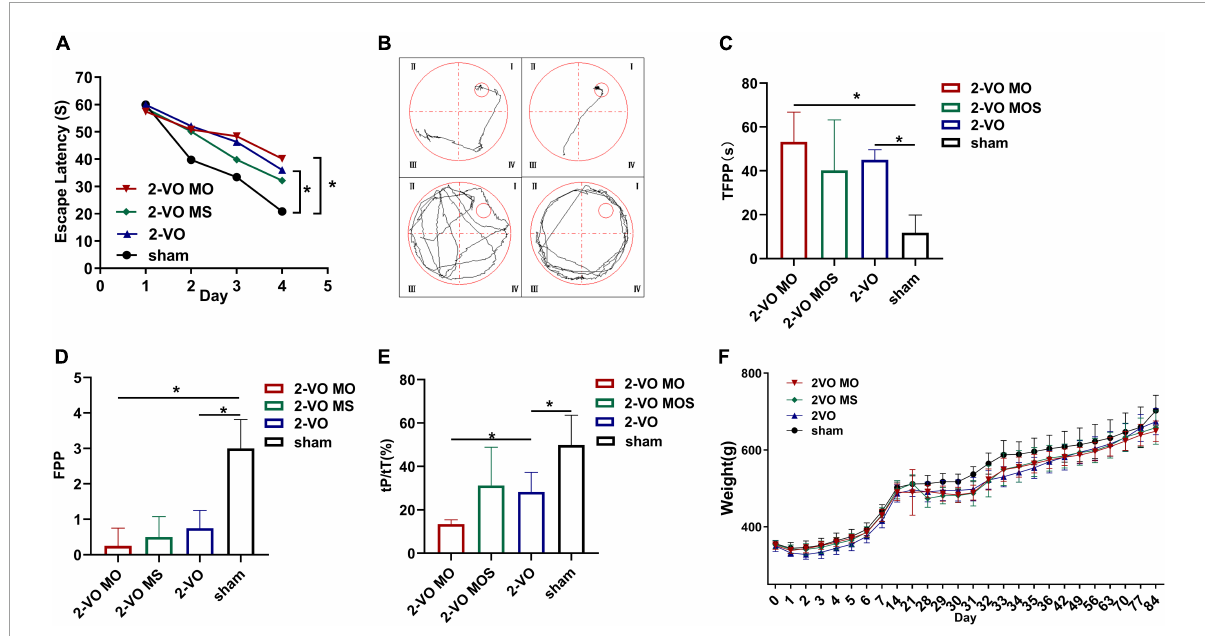
FIGURE2 Evaluation of memory and learning function via Morris water maze test. (A) Changes of escape latency in learning trial. (B) Representative traces of the probe test in the water maze test; (C) the time of first passing the platform (TFPP). (D) The frequency of passing the platform (FPP) in each group. (E) Time spent in the target quadrant of four groups in the probe trial. (F) Body weight changes in groups (All values are expressed as mean ± SD, n = 10, * p <